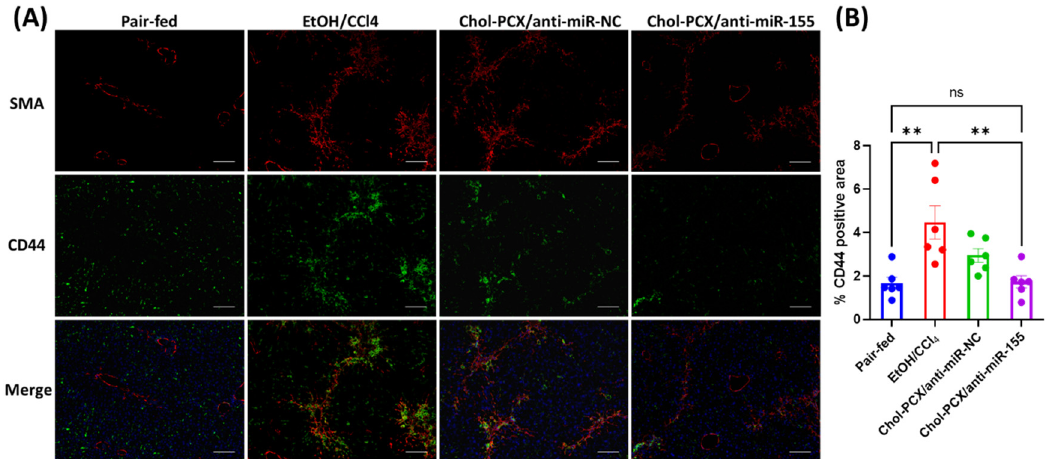
Figure 14. Immunohistochemistry for α -SMA (activated HSCs stain) and CD44. ( A ) Red fluorescence representing α -SMA and green fluorescence representing CD44. Scale bar = 100 μ m. ( B ) CD44- positive area quantification from the confocal images. Data were analyzed by one-way ANOVA followed by Turkey’s comparison test. All data are shown as mean ± SEM ( n = 6). ** p < 0.01, ns not significant.